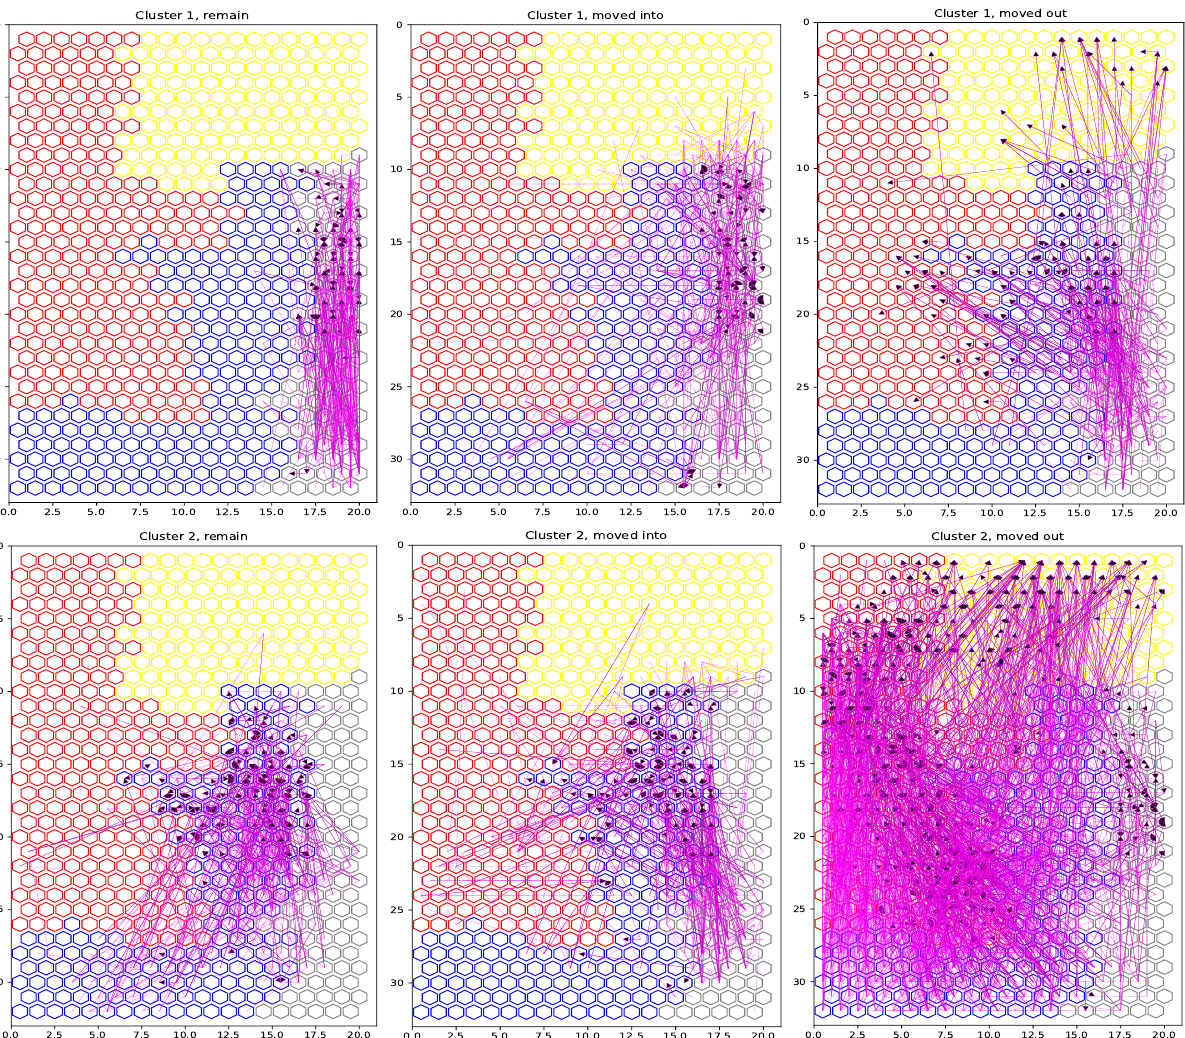
Figure A4. Visualization of longitudinal trajectories (part I). Cluster 1 is represented in gray; Cluster 2 in blue; Cluster 3 in red; and Cluster 4 in